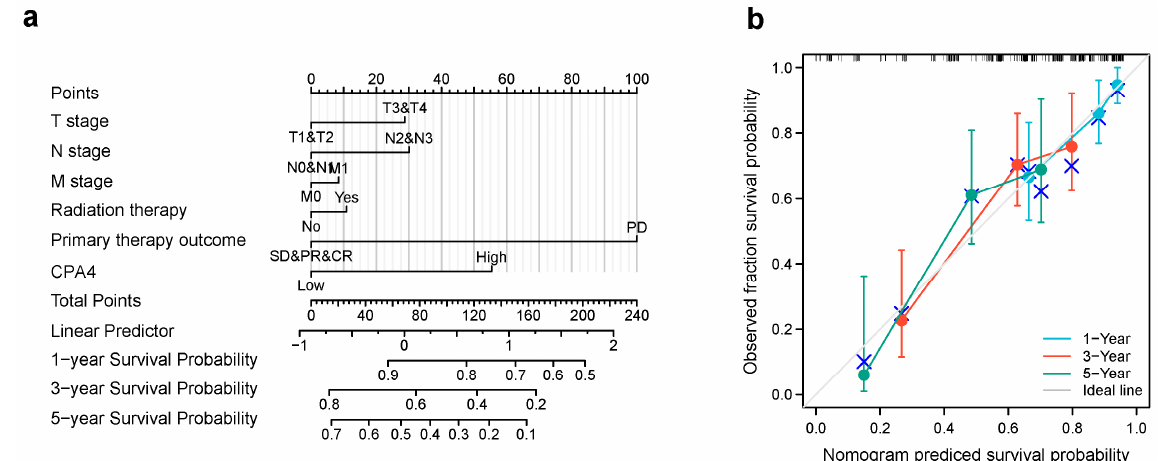
Figure 6. The relationship of CPA4 expression with other clinical factors and overall survival (OS). ( a ) Nomogram for predicting the probability of 1-, 3-, and 5-year OS for BLCA patients; ( b ) calibration plot of the nomogram for predicting the OS likelihood.